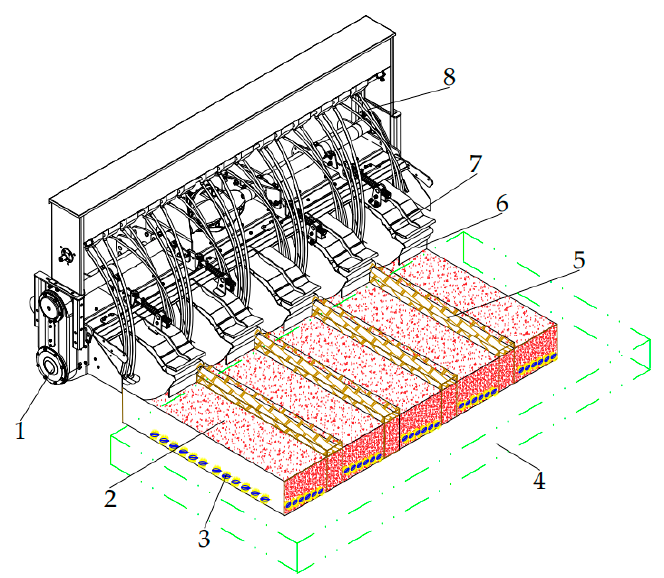
Figure 5. Axial schematic diagram: (1) gear train; (2) seed box; (3) seeds; (4) sowing space; (5) straw-crushing concentrated area; (6) soil-retaining plate; (7) upper baffle; (8) seed tube.